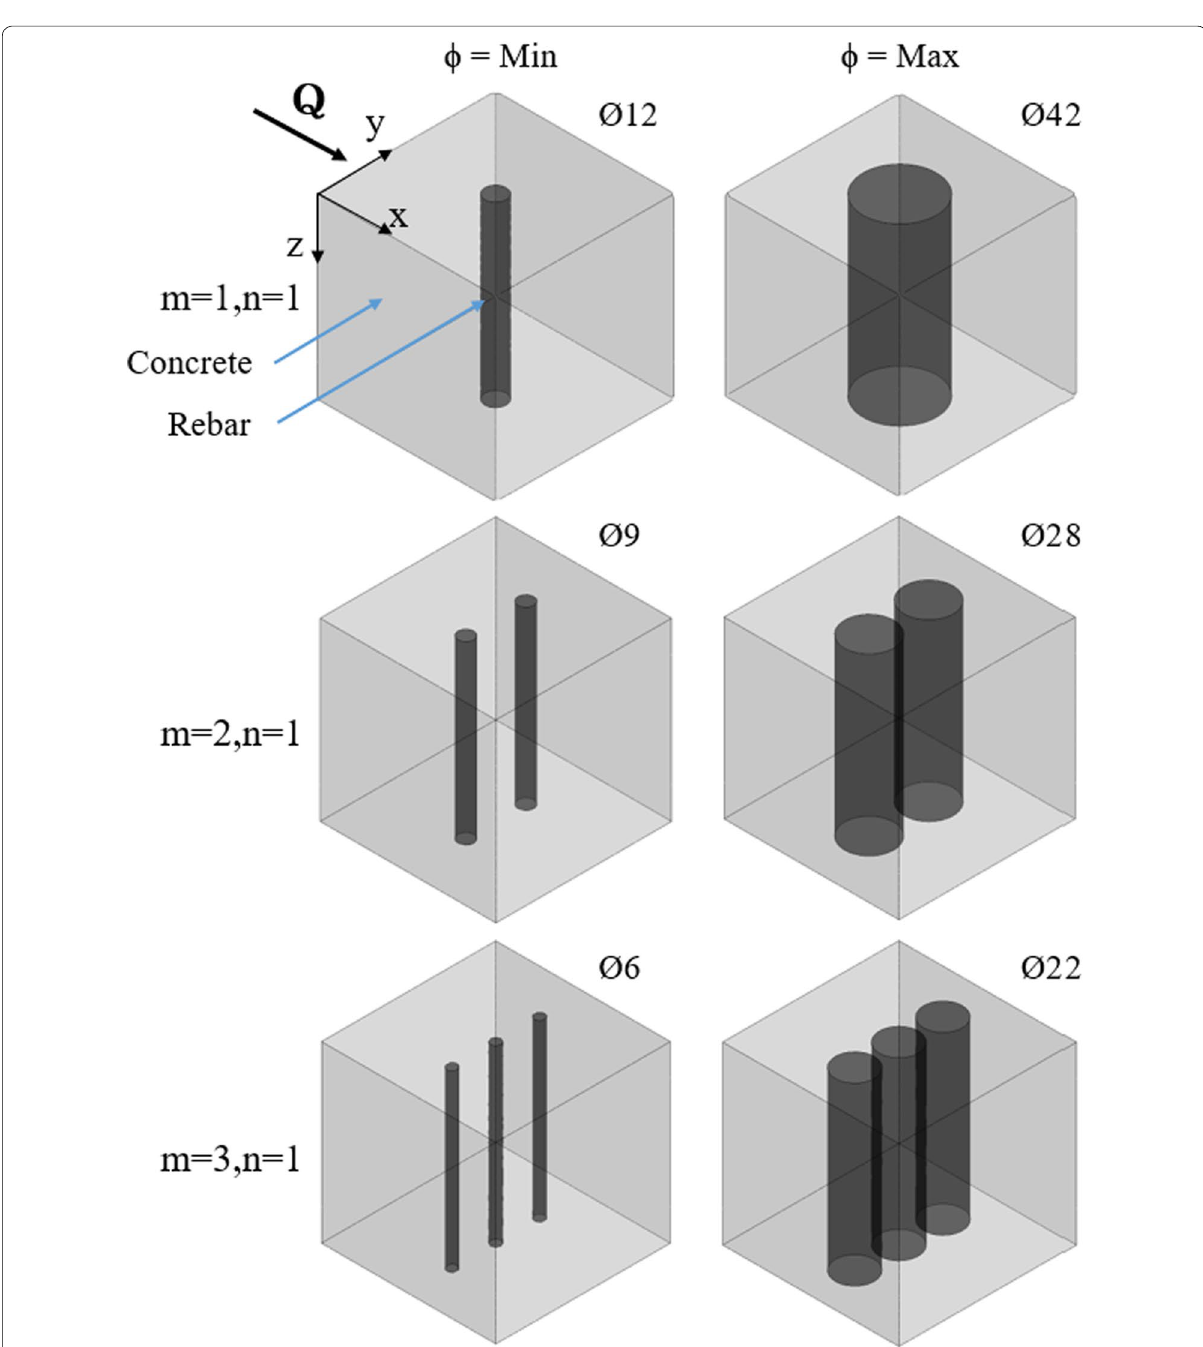
Fig. 5 Numerical domain in reinforced concrete as volume fraction and the number of